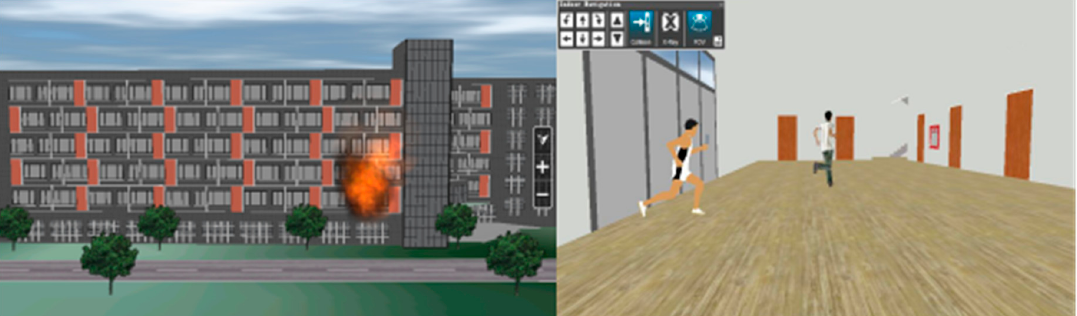
Figure 4. The indoor and outdoor fire scene.